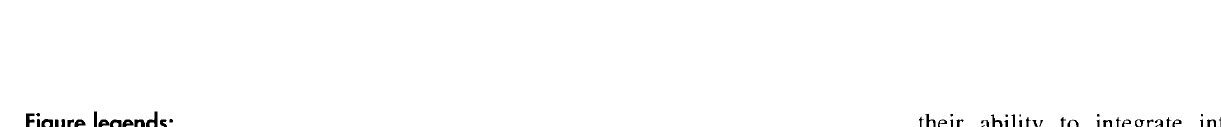
Figure legends: Figure 1: Percentage change in student performance in each of the four clinical blocks and clinical rotations. The numbers at the top of each bar represents the block in which the students w ere at a particular time. Student group 1 started in block four, proceeded to block 3, then block 2 then block 1. Student group 2 rotated from block 1 to block 4 to block 3 to block 2. Student group 3 rotated from block 2 to block 1 to block 4 to block 3. Student group 4 rotated from block 3 to block 2 to block 1 to block